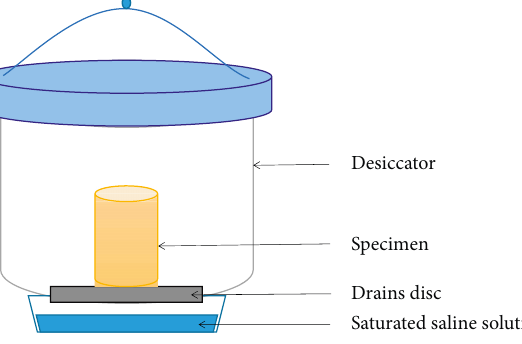
Figure 3: Schematic diagram of desiccator with